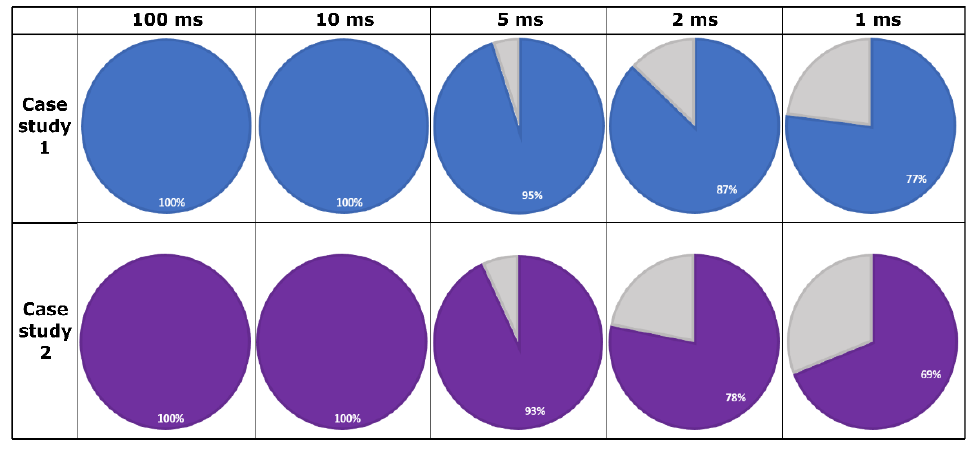
Figure 7. Data buffering success rate results.